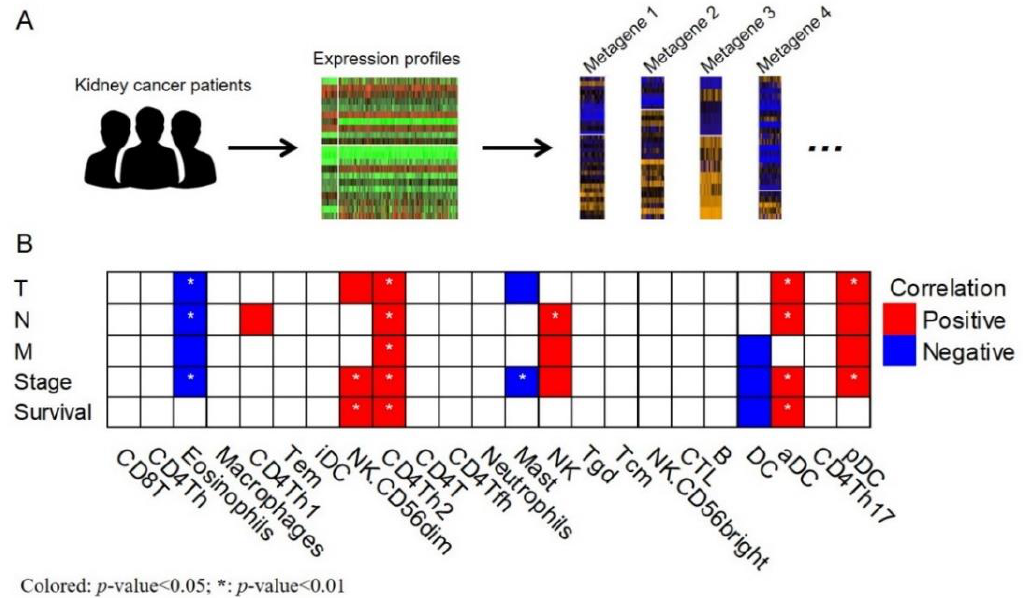
Figure 6. Correlation between immune metagenes and clinical characteristics. ( A ) Here is a schematic to explain the steps for construction of immune metagenes. In brief, expression values of renal papillary cell carcinoma (KIRP) patients were retrieved from The Cancer Genome Atlas (TCGA). For each category of 23 immune metagenes, single sample GSEA (ssGSEA) algorithm was adopted to calculate enrichment score (metagene score) of each patient / specimen. ( B ) Heatmap is the correlation results between immune metagenes and several clinical features (depth of invasion, T; lymph node metastasis, N; distant metastasis, M; pathological staging, stage; and overall survival). Color: red and blue for positive and negative correlation, respectively (without *: p -value < 0.05; with *: p -value < 0.01); white for nonsignificant ( p -value > 0.05).